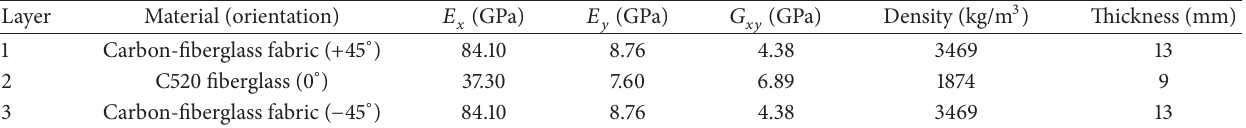
Table 1: Material properties for the wind turbine blade model.